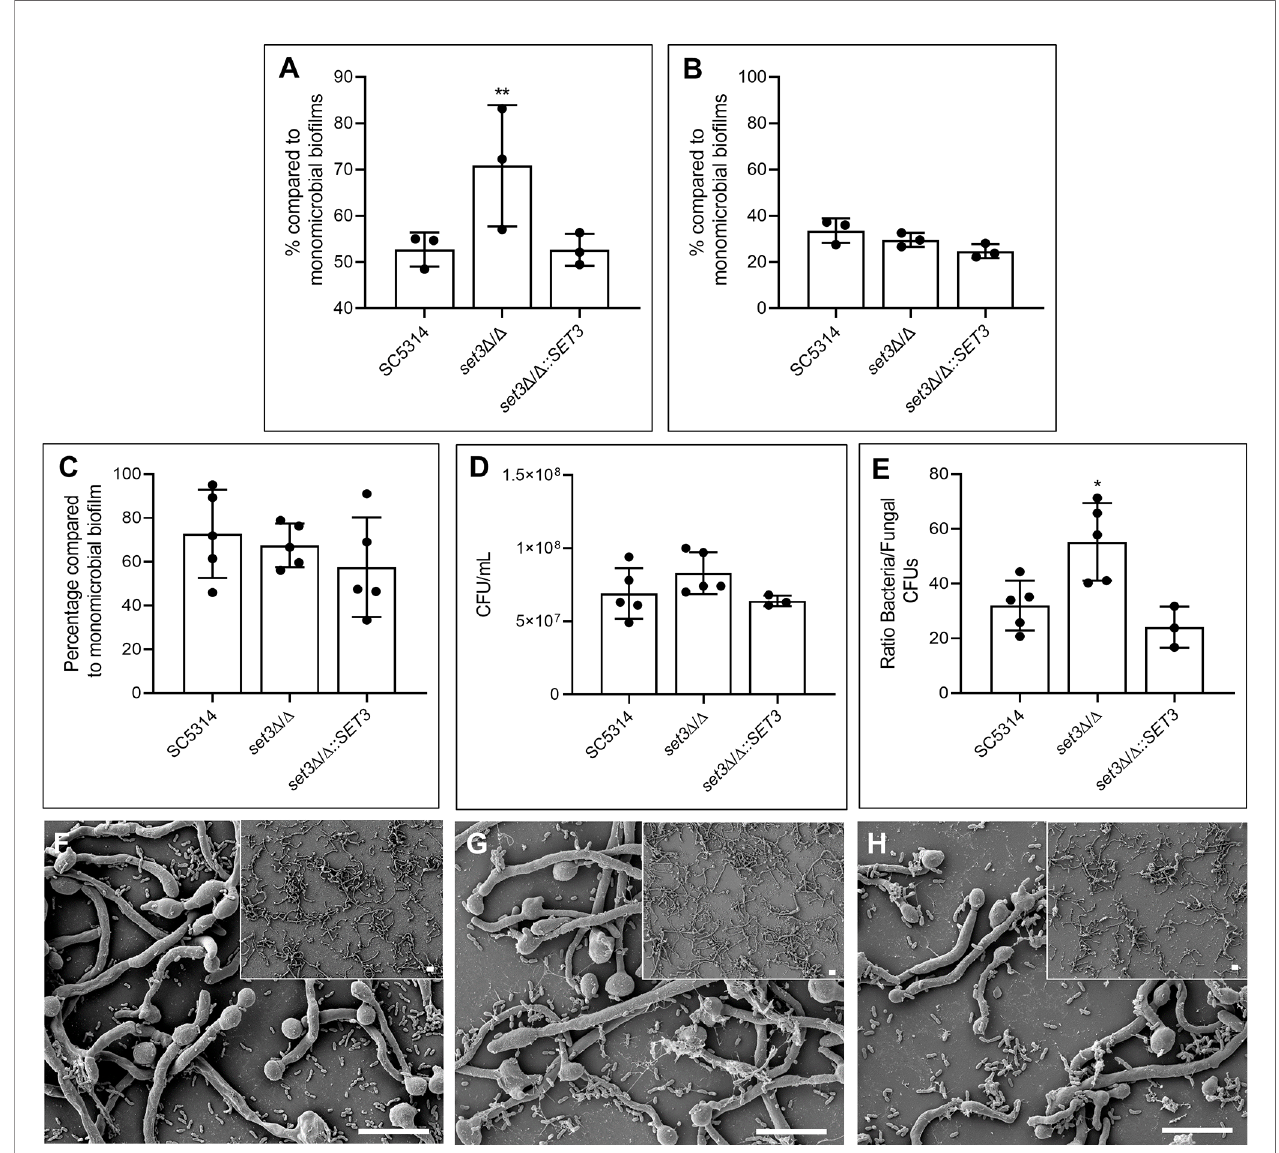
FIGURE 2 | Effect of SET3 deletion on Candida albicans polymicrobial bio fi lms with Pseudomonas aeruginosa . Polymicrobial bio fi lm biomass after 6 h (A) and 48 h (B) of the homozygous mutant of SET3 ( set3 D / D ) as well as the homozygous mutant with add-back of the wild-type gene ( set3 D / D ::SET3 ) with P. aeruginosa . Colony forming units (CFU) of mature C. albicans bio fi lms are indicated in (C) and P. aeruginosa CFUs in (D, E) indicates the ratio of bacterial/fungal CFUs. (F) (SC5314), (G) ( set3 D / D ) and (H) ( set3 D / D ::SET3 ) indicates the morphology of mature polymicrobial bio fi lms. Small panels on right corners indicate bio fi lms with lower magni fi cation. Scale bars on all panels indicate 10 m m. *Signi fi cantly different from wild type (SC5314) (* P < 0.05; ** P <